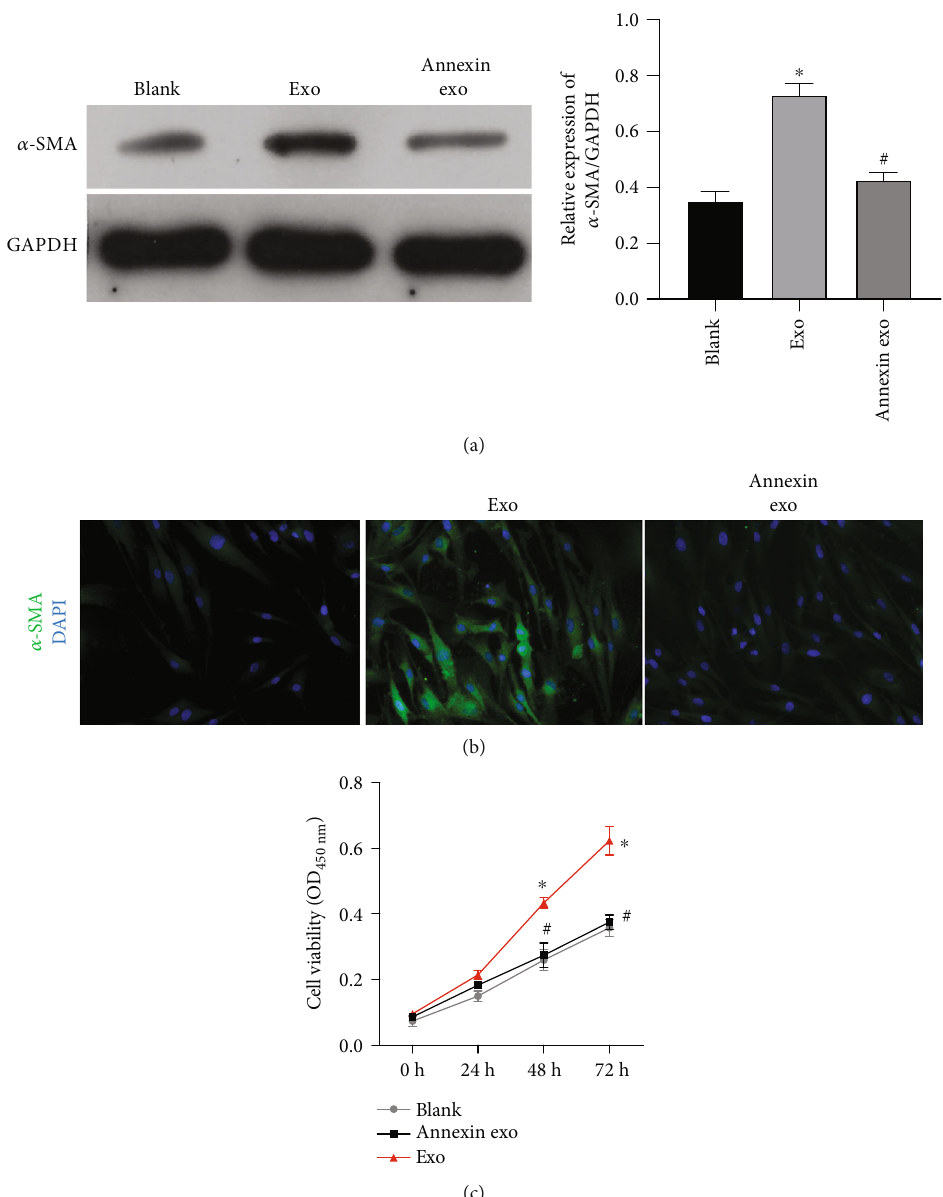
Figure 4: α -SMA expression, cell fi brogenesis, and cell viability were attenuated in HSCs treated with exosomes that had been preincubated with annexin. (a) Western blotting was used to measure α -SMA expression. (b) Immuno fl uorescence assays were performed to measure α - SMA expression. (c) Cell viability was determined by the CCK-8 assay. ∗ p < 0 : 05 vs. blank; # p < 0 : 05 vs.